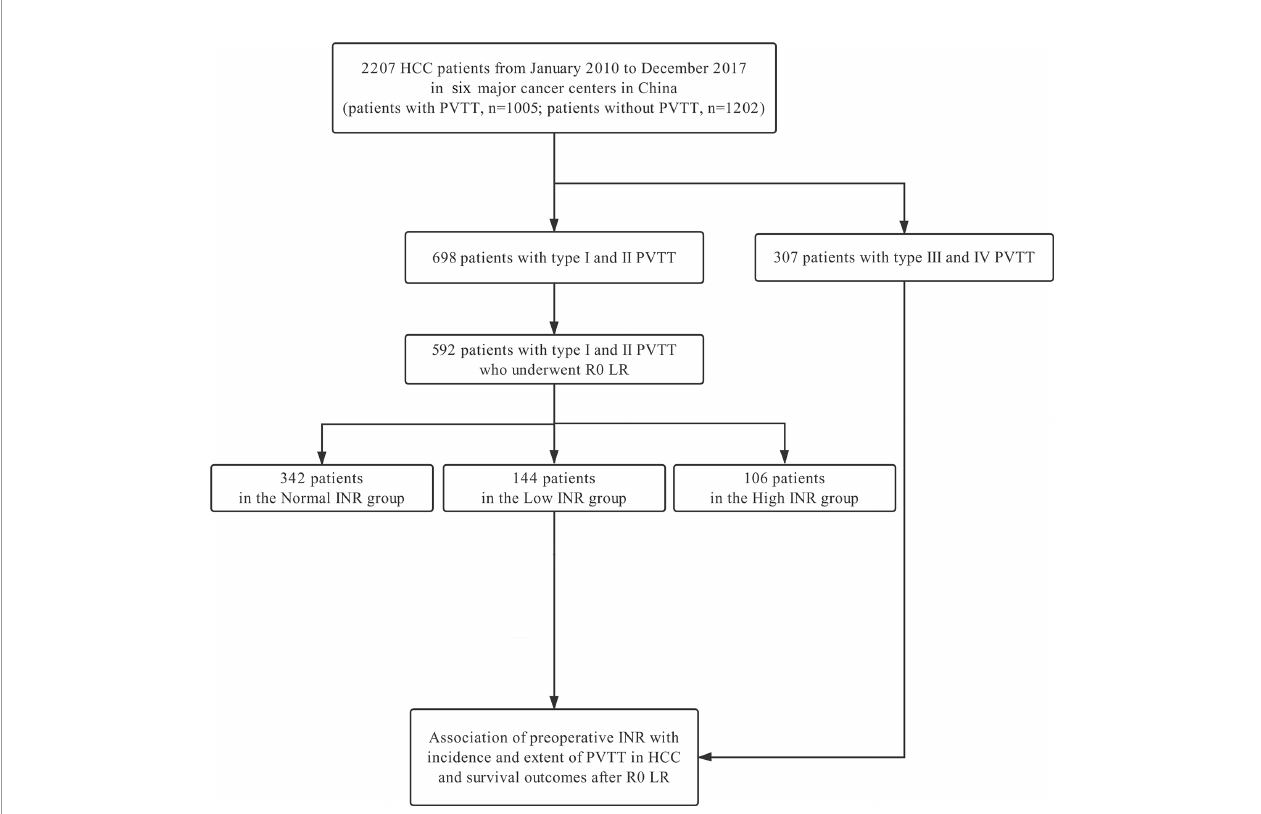
FIGURE 1 | Flowchart of patient selection for the study. HCC, hepatocellular carcinoma; PVTT, portal vein tumor thrombus; LR, liver resection; INR, international normalized